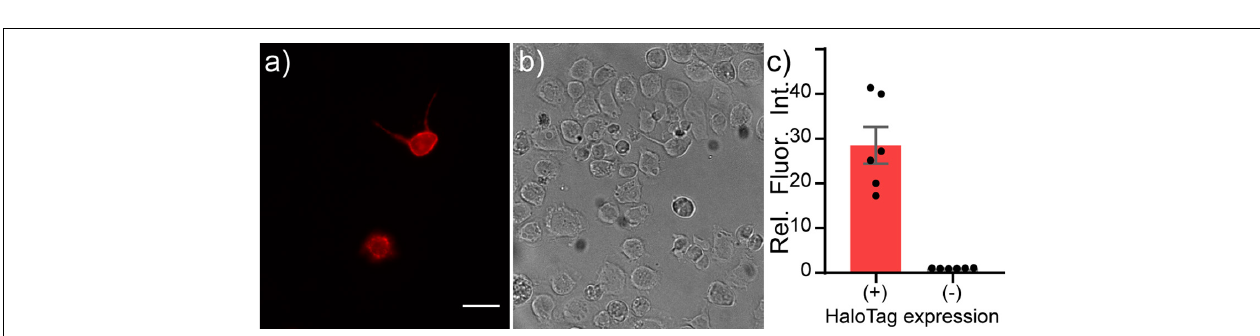
FIGURE 3 | Live-cell staining of Drosophila S2 cells with TMR-Halo. Live-cell staining of TMR-Halo in Drosophila S2 cells expressing HaloTag-CD4. Epifluorescence images of Drosophila S2 cells transfected with tubP-GAL4 and HaloTag-CD4 UAS and (a) stained with TMR-Halo (100 nM). (b) Transmitted light image of cells in panel (a) . Scale bar is 20 µ m. (c) Plot of relative fluorescence intensity in cells expressing HaloTag vs. cells that do not express HaloTag from the same cultures. HaloTag-(+) cells were assigned based on a threshold obtained from a non-transfected control. Data are mean ± SEM for n = 6 different coverslips.